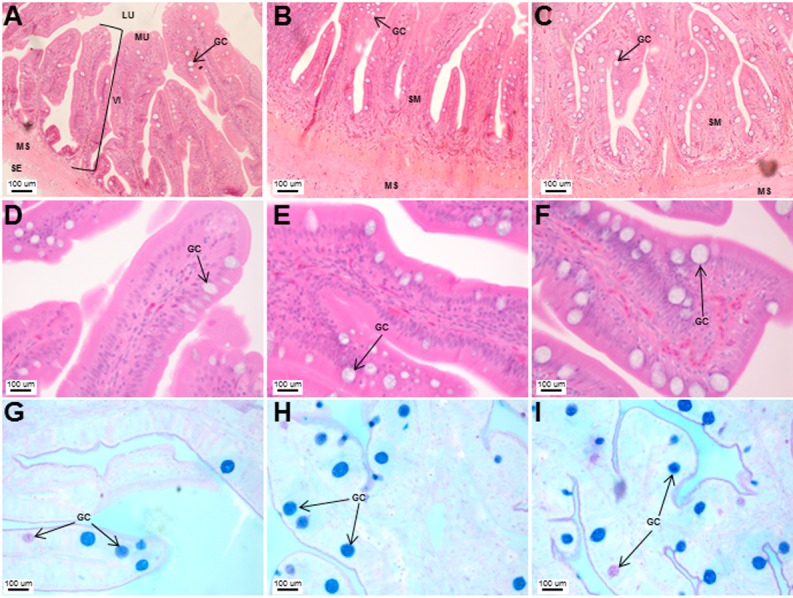
Histological analyses of the Asian seabass intestine did not reveal major differences from the anterior to posterior portion with the exception of goblet cell numbers.Transverse sections of the Asian seabass intestine stained with (A, B and C: 10X; D, E and F: 63X) H&E and (G, H and I: 63X) PAS-AB pH 2.5. The anterior, mid and posterior regions are shown in (A, D, G), (B, E, H) and (C, F, I), respectively. Abbreviations: Villi (VI), lumen (LU), mucosa (MU), submucosa (SM), muscularis (MS), goblet cells (GC) and serosa (SE).